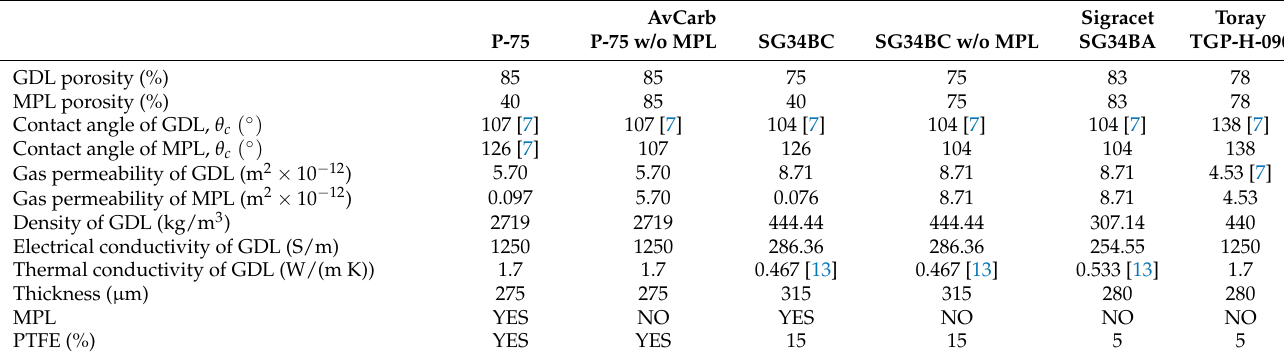
Table 3. Physical and transport properties of GDLs and MPLs.